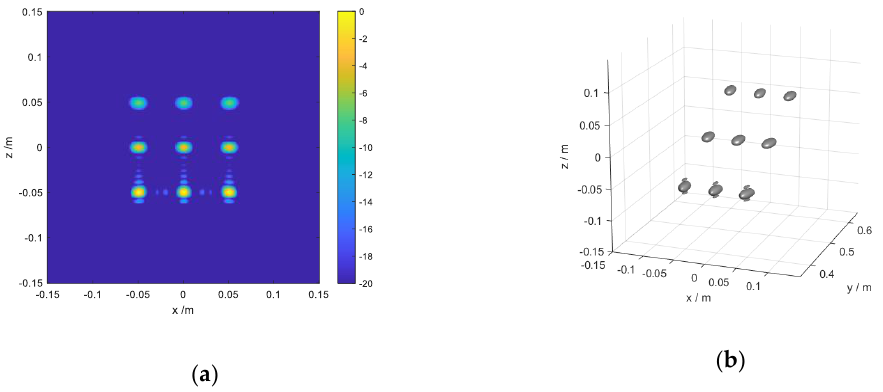
Figure 8. Imaging results of nine identical spheres: ( a ) 2D imaging result; ( b ) 3D imaging result.